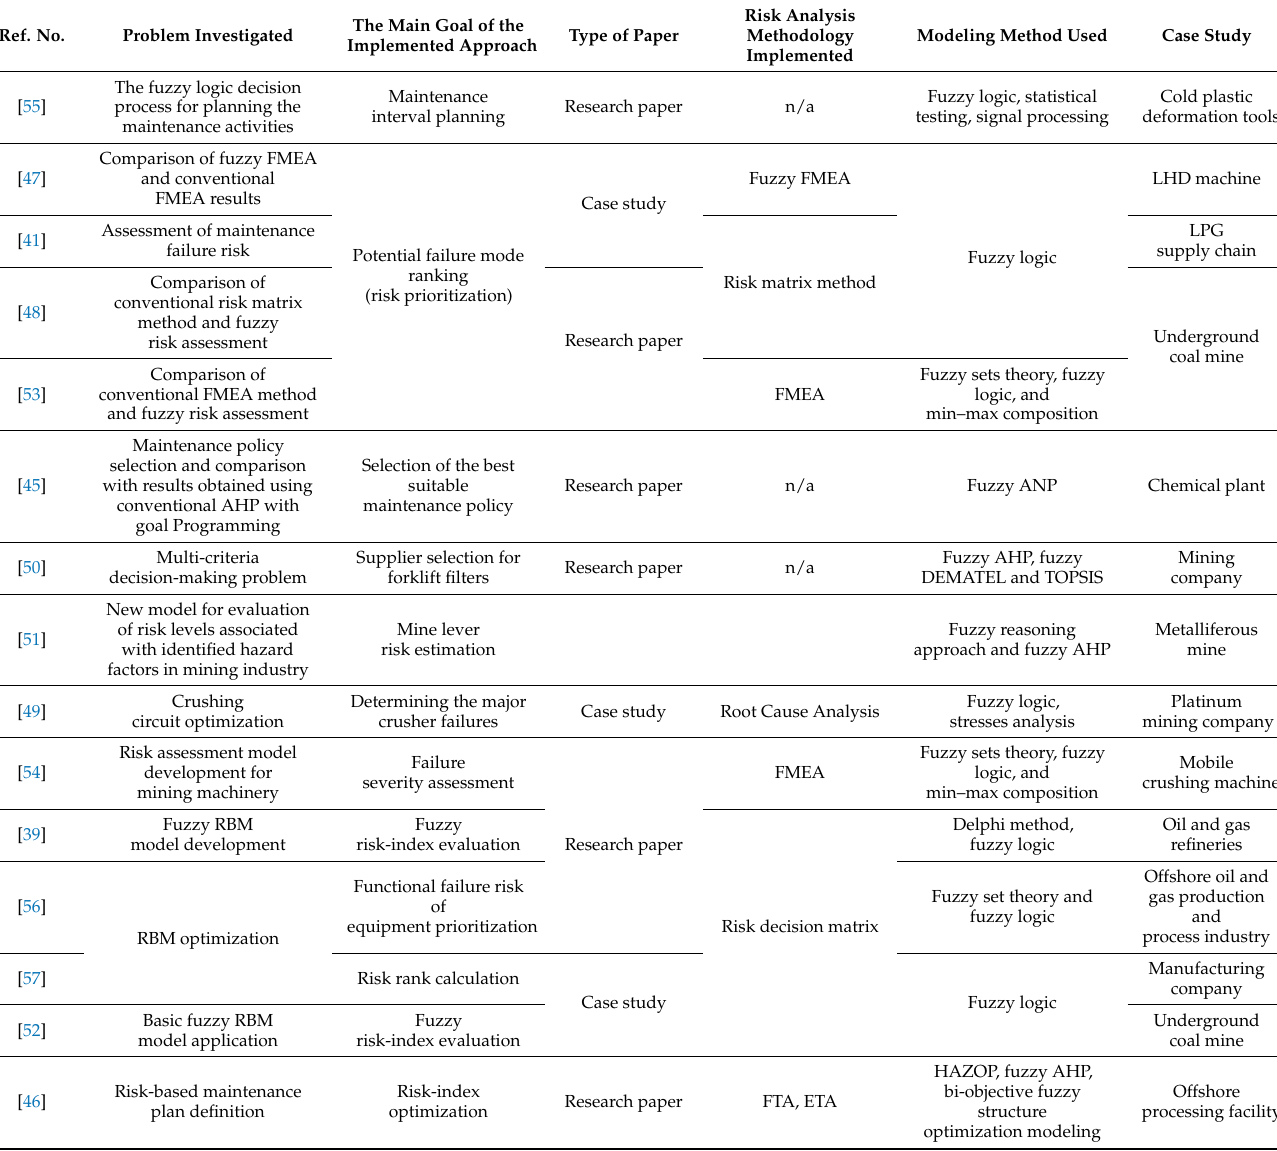
Table 1. Summary of reviewed literature on fuzzy